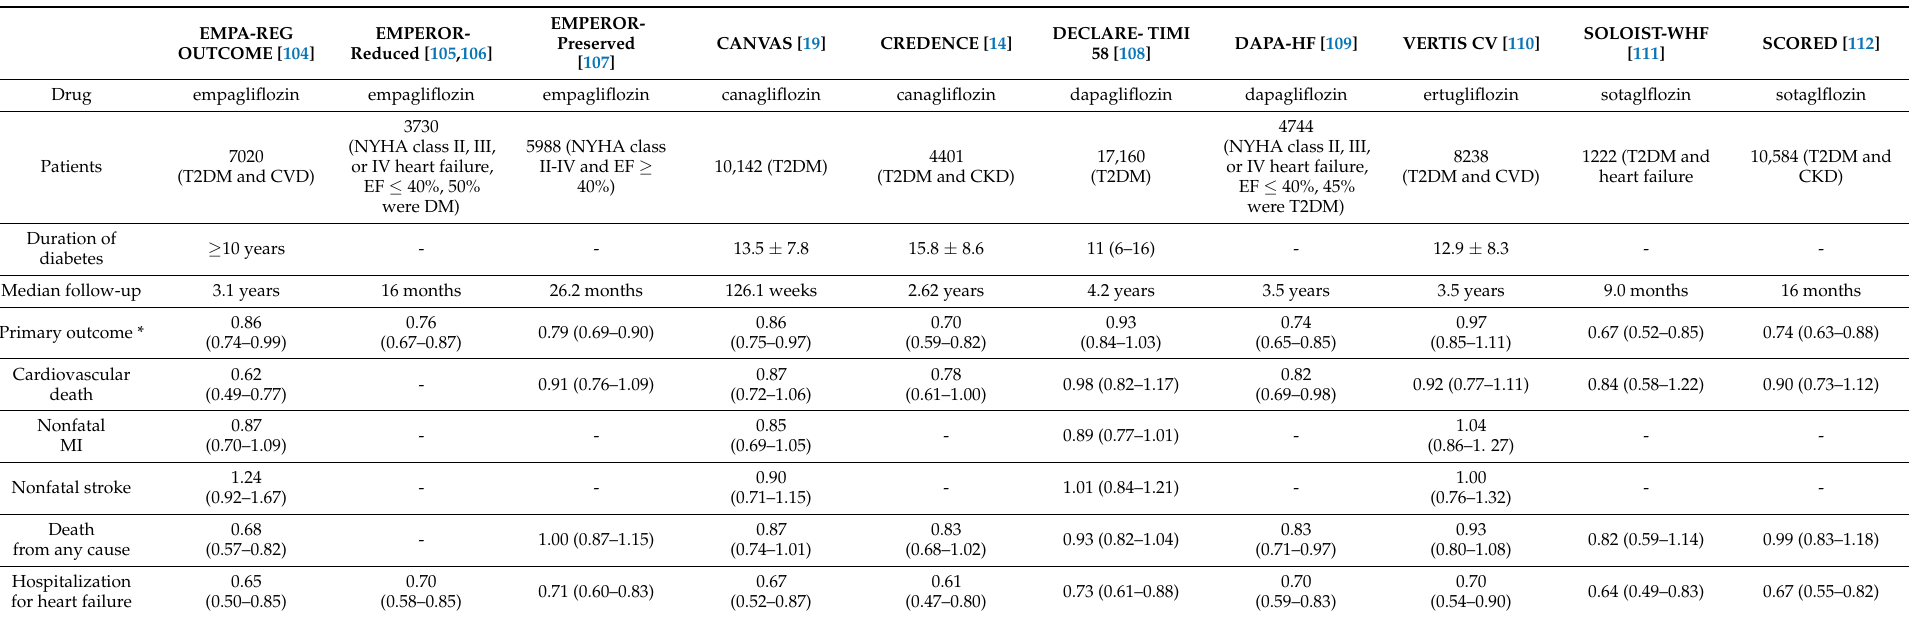
Table 2. Reported cardiovascular outcome trials of SGLT2